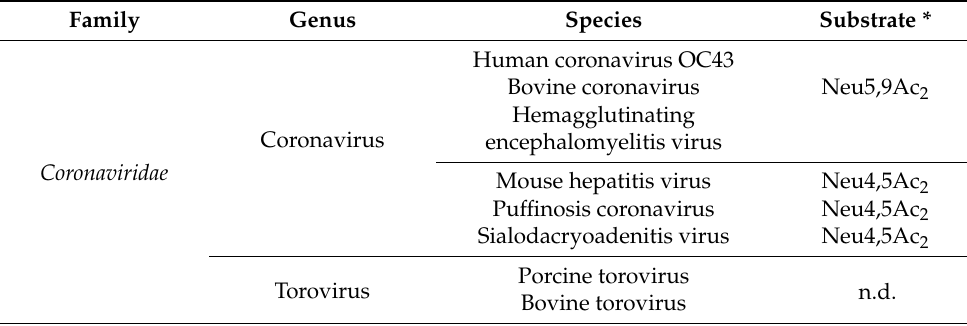
Figure 4. The scheme of SDAV replication: own work based on available knowledge. (1) SDAV HE probably mediates weak interactions with abundant host cell surface sialates, keeping the virus concentrated on cells before connecting S protein with the still unknown cell receptor. (2) S-glycoproteins then bind to protein receptors and are proteolytically activated (by cutting with specific proteases: TMPRESS2 or furin) into two subunits, S1 and S2, to conformations that induce membrane fusion. (3) Virus–cell fusion involves S binding to sialic acids. The likely route of entry into the cell is cell–virus fusion associated with S-protein connections to sialic acids. Connections to host cell receptors may not be required for this process, thus allowing distribution, beginning with the binding of viral protein S (RBD/S1) on the host cell receptor, driving a conformational change in the S2 subunit and facilitating its fusion with the plasma membrane and ultimately the release of viral genome (+ ssRNA) into the cytoplasm. However, the route by which SDAV enters the cell is still unknown and also can be mediated by acidified endosomes. (4) Promptly, the translation produces nonstructural pp1a and pp1ab co-terminal polyproteins (pp1a and pp1ab) that are proteolytically cleaved and assembled into a functional replicase–transcriptase complex: RTC. (5) Viral RNA synthesis produces copies of gRNA, as well as a nested set of sgRNA. This is possible by discontinuous transcription of a negative-sense RNA intermediate. (6) Following replication and sgRNA synthesis, various structural and accessory proteins are translated into the endoplasmic reticulum (ER) and (6a) then assembled as virion in the endoplasmic reticulum-Golgi intermediate component (ERGIC), along with viral genomes encapsulated by N protein budded into membranes of the ERGIC. (7) Then, virions are transported in vesicles and exit cells via exocytosis. Table 1. Examples of viruses expressing the O-acetylesterases. Based on